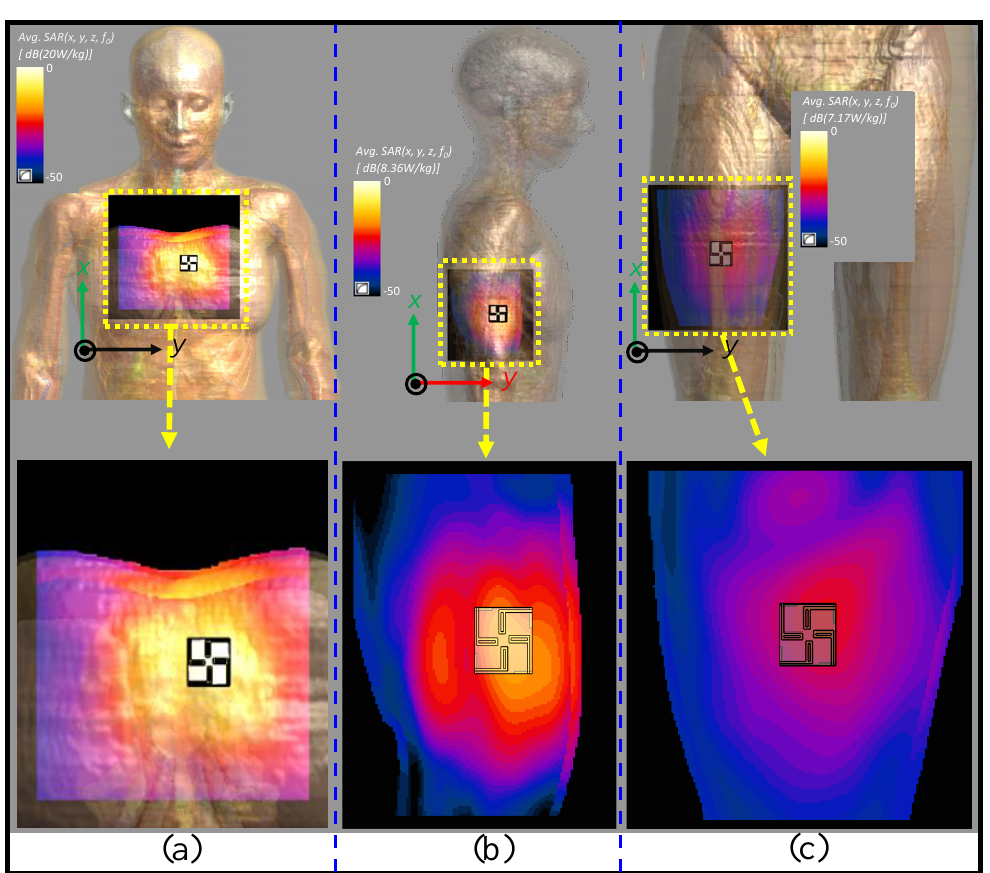
Figure 10. Specific absorption rate (SAR) analysis of the MIMO antenna on ( a ) chest, ( b ) arm, and ( c ) leg. Additionally, the antenna’s performance in terms of reflection coefficient, gain, and radiation pattern is evaluated in the vicinity of the human body. The reflection coefficient of the antenna in free space and in on-body worn scenarios is illustrated in Figure 11a. We can see that the resonant frequency shifts a bit towards the lower frequency side due to body loading effects [51]; however, the antenna still retains a good impedance bandwidth and covers the targeted ISM band (2.4 GHz). Figure 11b,c illustrate the radiation pattern of the antenna in free space and in the vicinity of the human body. We can see that the front-to-back ratio of the antenna in Phi = 0 0 is enhanced due to the fact that skin behaves as an extension of the ground plane